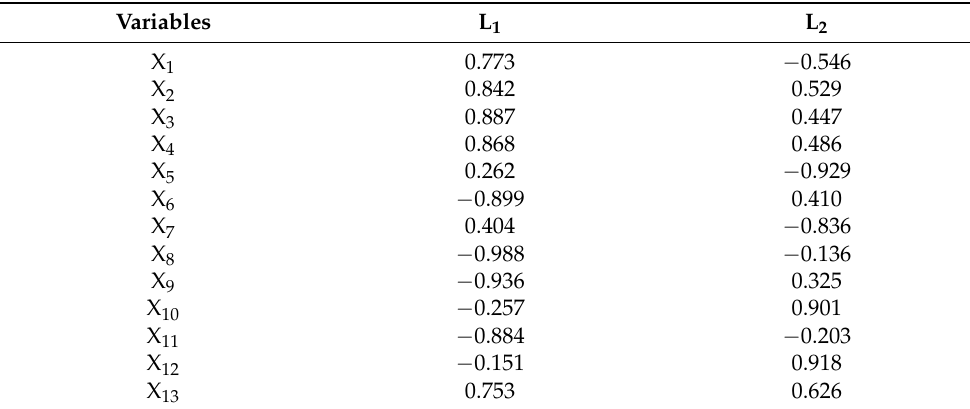
Table 3. Principal component load matrix.